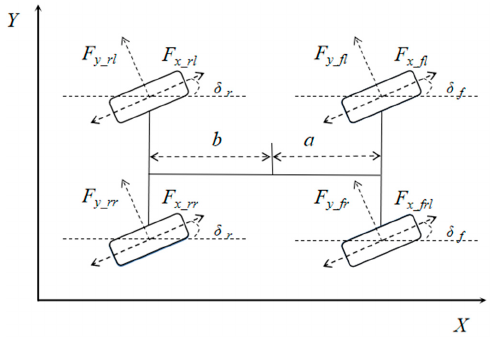
Figure 1. Vehicle dynamics model.